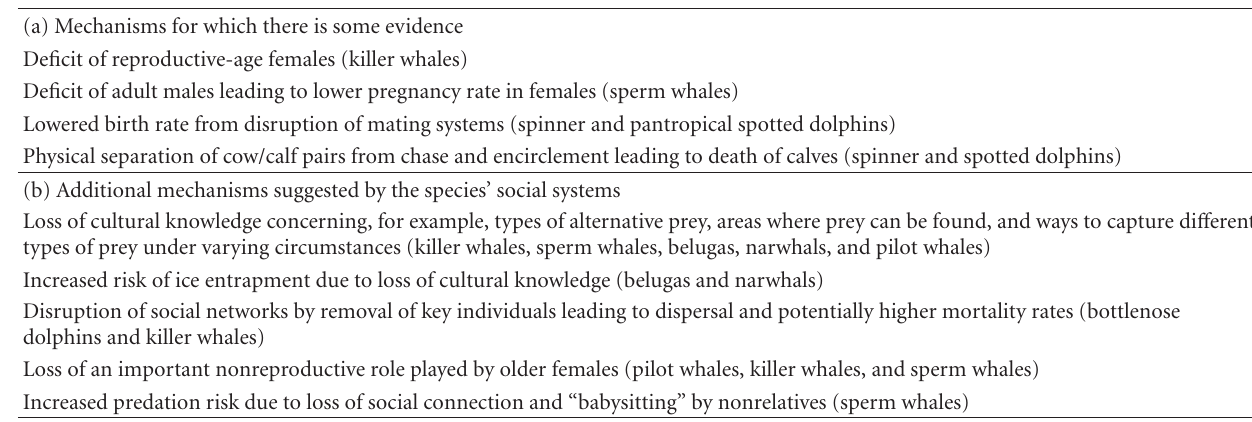
Table 1: Possible mechanisms by which direct exploitation a ff ects odontocete cetaceans, beyond the simple e ff ect on population dynamics of removing individual